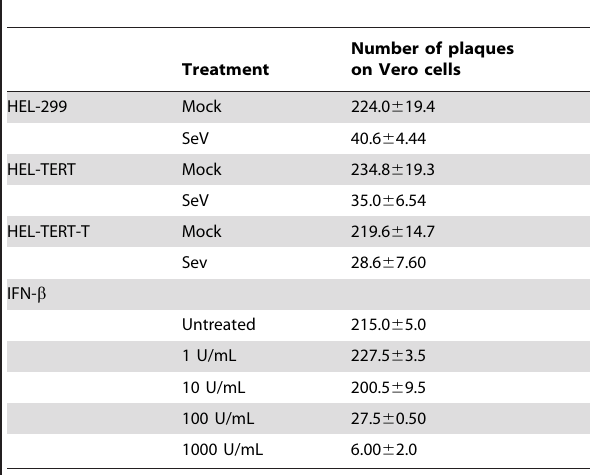
Table 1. Ectopic hTERT expression does not affect the ability of HEL cells to produce antiviral cytokines.